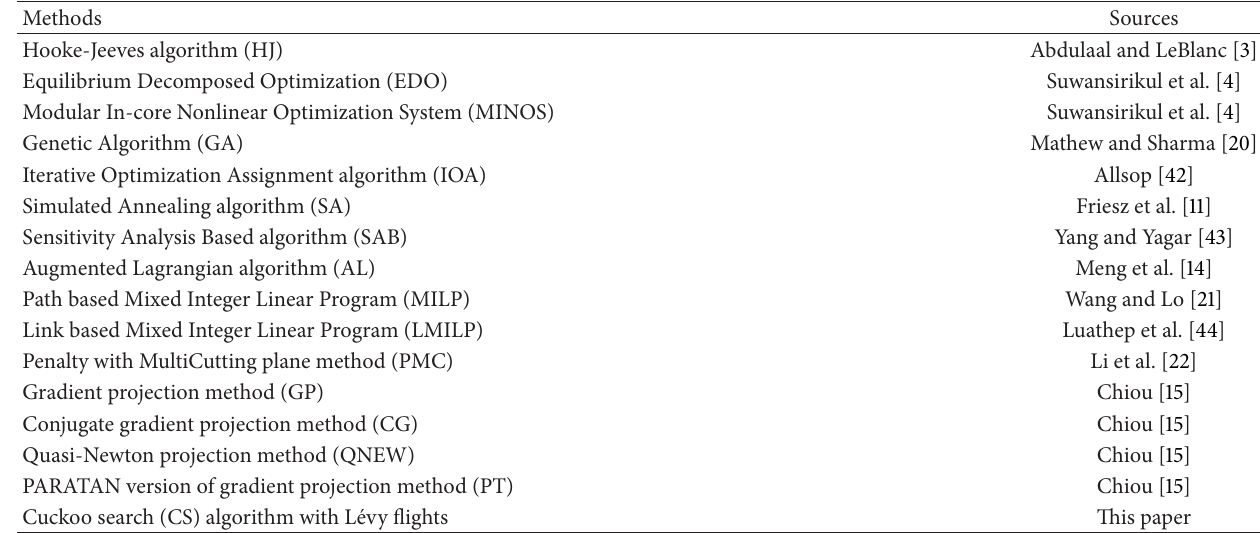
Table 2: The compared algorithms on all test networks.